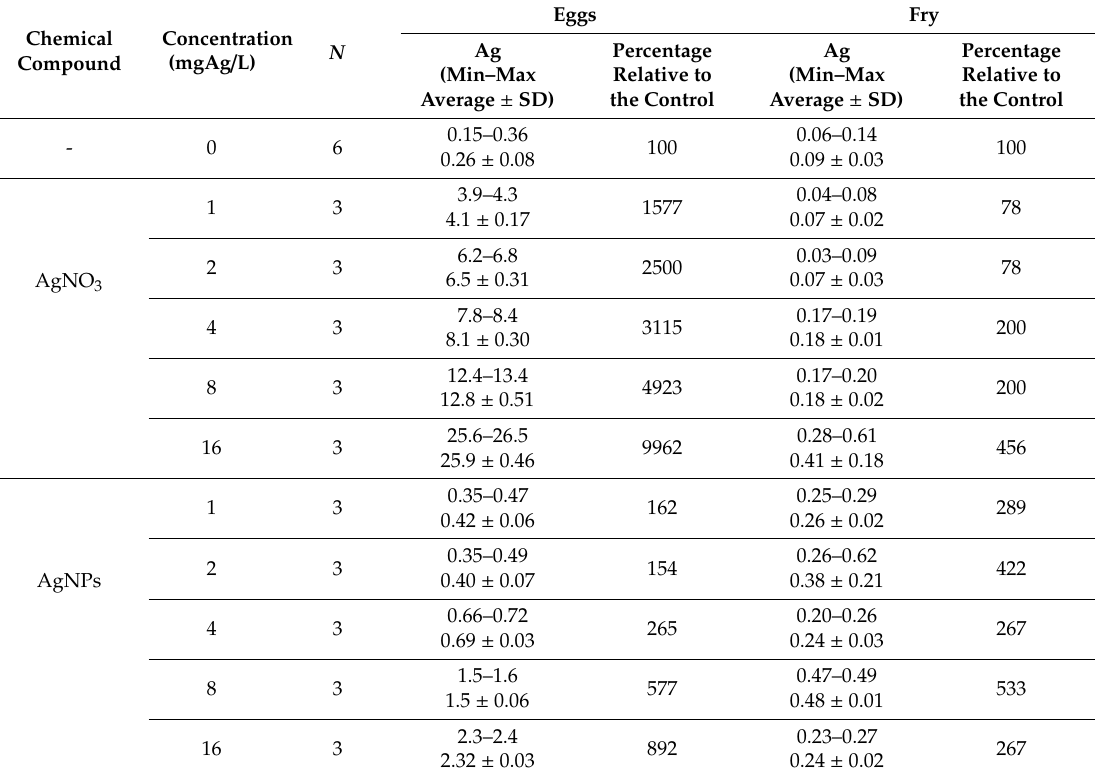
Table 1. Silver nanoparticles (AgNPs) and ionic Ag (Ag + ) contents in rainbow trout eggs and fry (mg / kg w.w.) after an application of different concentrations of Ag in the form of AgNO 3 or AgNPs (mgAg / L). Chemical Compound